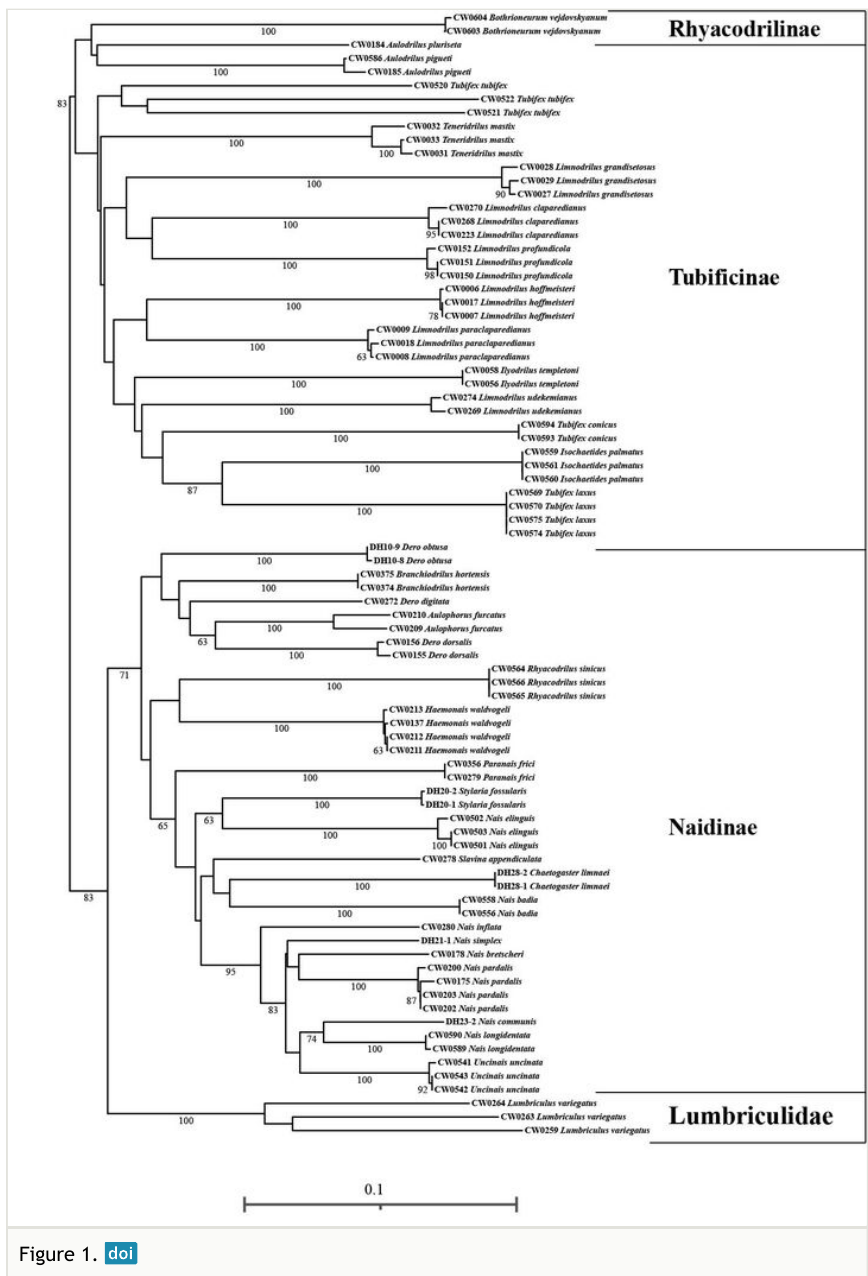
Figure 1. Phylogenetic tree of the COI gene, based on Neighbour-Joining analysis of Naididae. Bootstrap support > 60 are